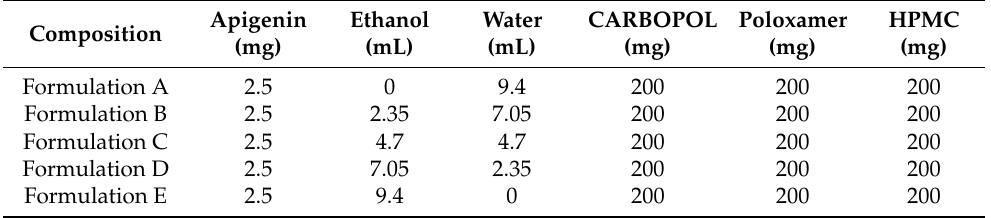
Table 1. Drug formulations as printer